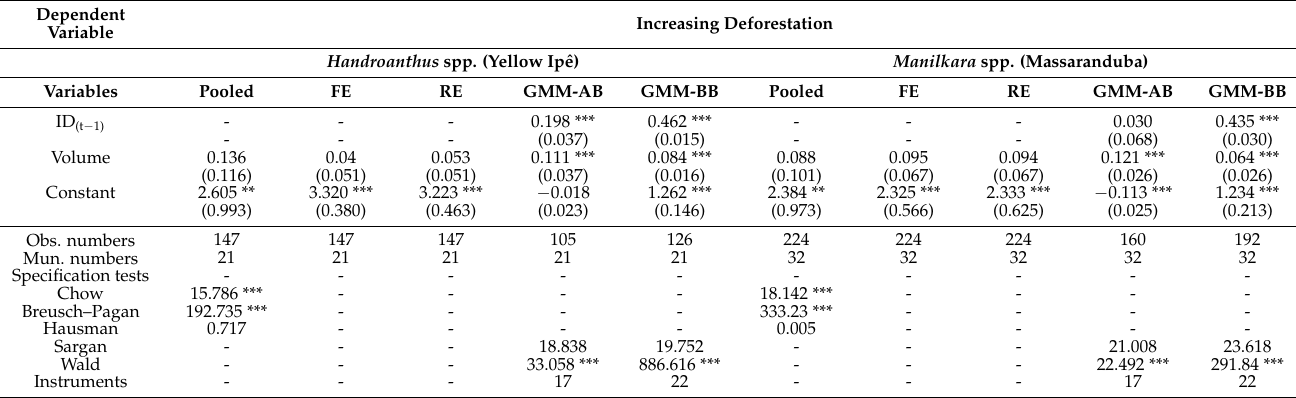
Table 6. Results of panel models of deforestation increase in relation to volume (m 3 ) for Handroanthus spp. and Manilkara spp. in the municipalities of Par á , from 2009 to